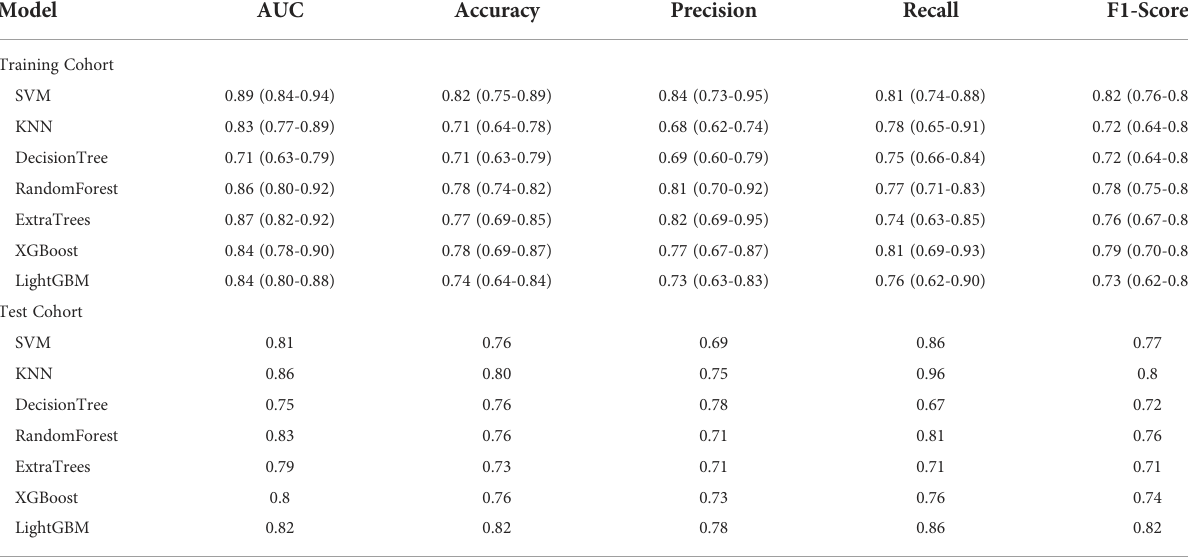
TABLE 2 The performance of radiomics features for the prediction of ALN metastasis.